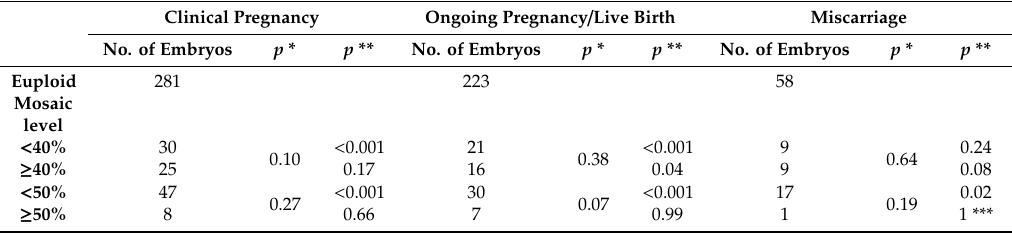
Table 3. Reproductive outcome of di ff erent levels of mosaicism compared to euploid embryo transfers. Clinical Pregnancy Ongoing Pregnancy / Live Birth Miscarriage No. of Embryos p * p ** No. of Embryos p * p ** No. of Embryos p * p ** Euploid 281 223 58 Mosaic level < 40% 30 < 0.001 21 < 0.001 9 0.24 0.10 0.38 0.64 ≥ 40% 25 0.17 16 0.04 9 0.08 < 50% 47 < 0.001 30 < 0.001 17 0.02 0.27 0.07 0.19 ≥ 50% 8 0.66 7 0.99 1 1 ***